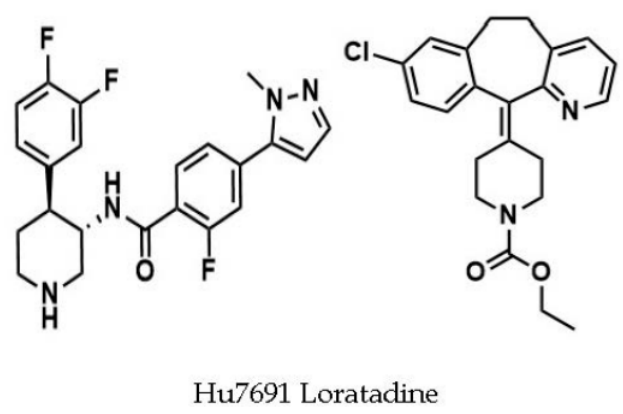
Figure 1. Chemical structures of Hu7691 and